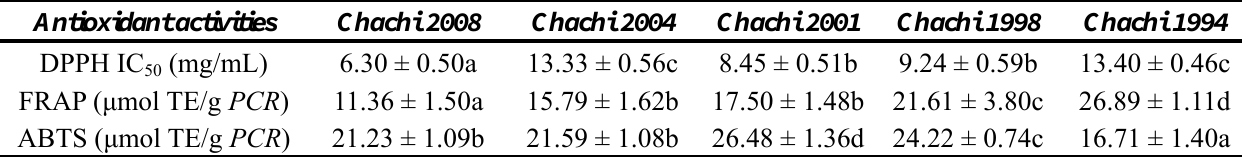
Table 3. The antioxidant activities of PCR essential oil at different storage